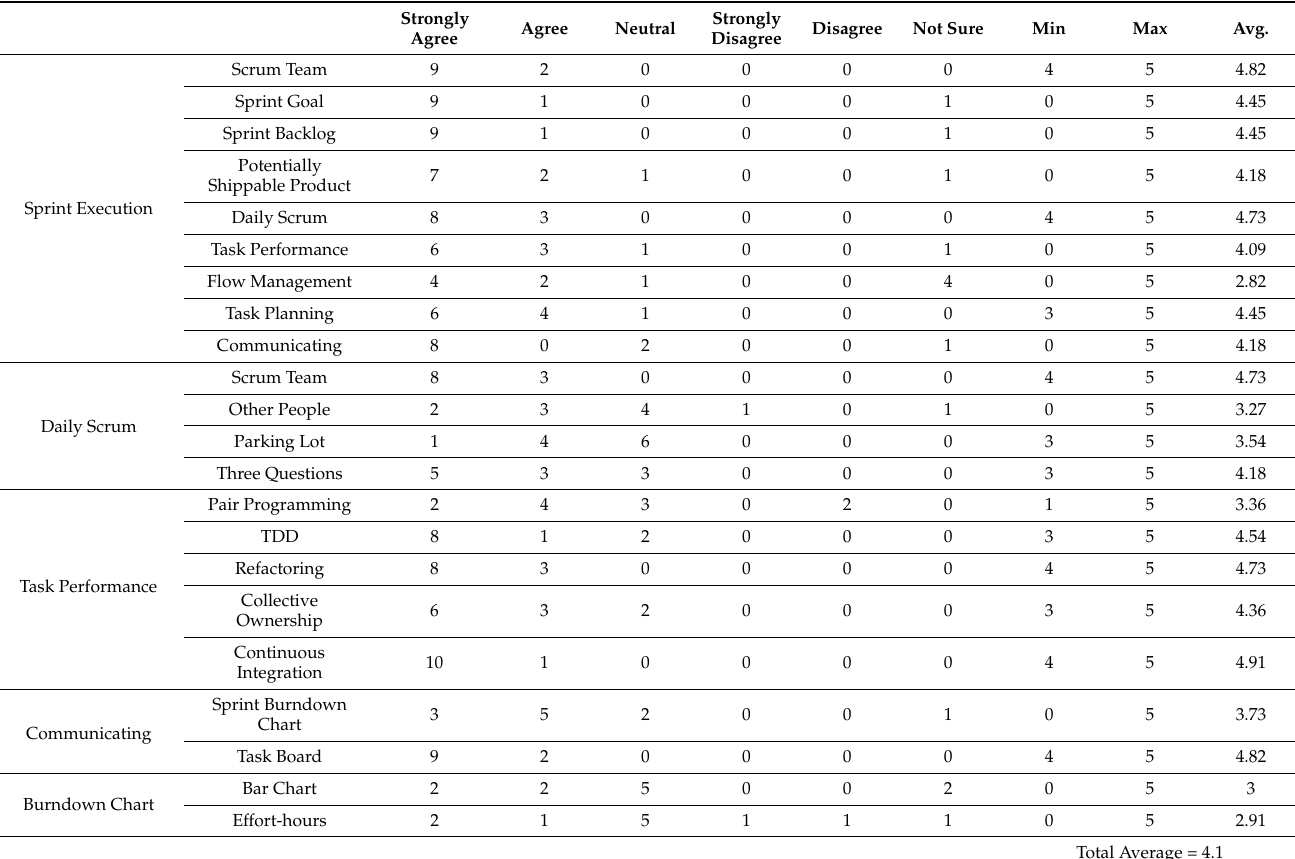
Table A8. Responses given to the suitability of the process elements identified by the